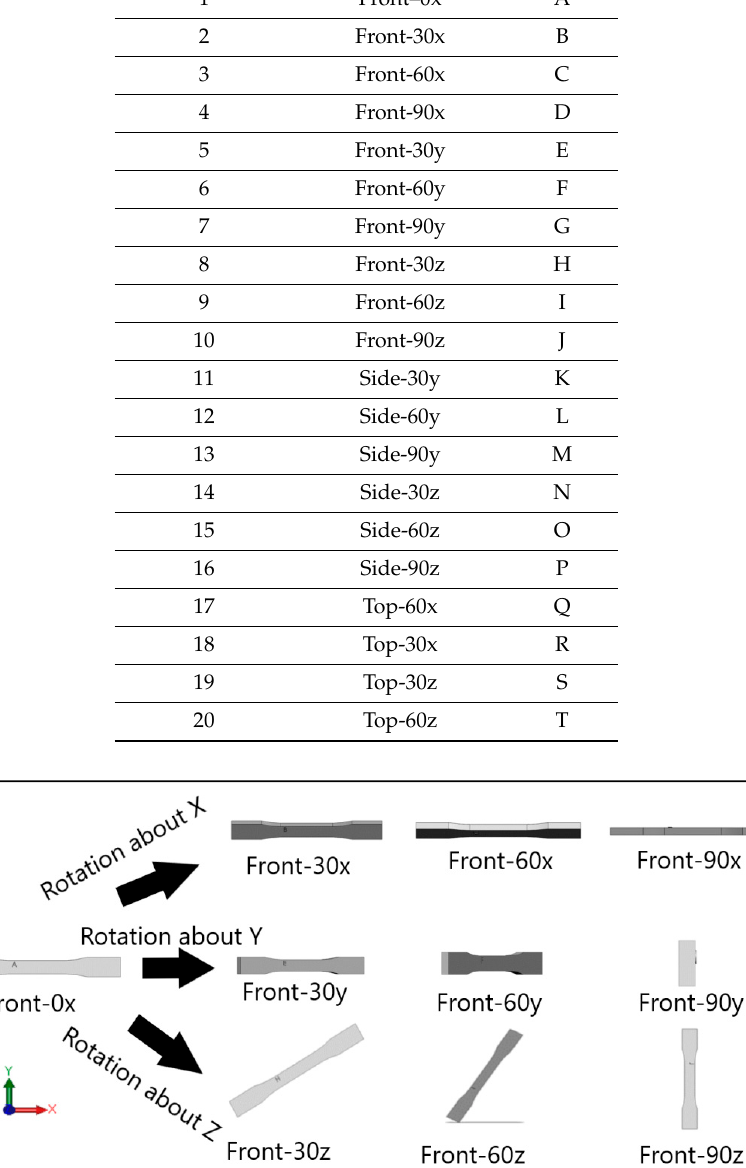
Figure 1. Front view of front-built samples, 0°, 30°, 60°, and 90° from left to right for each axis rotation (separate rows for x, y, and z-axis), respectively.